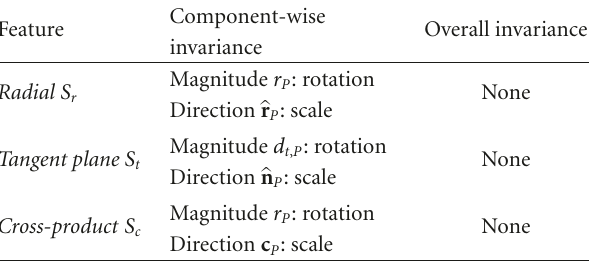
Table 2: Local geometric features and their invariance properties (assuming that the barycenter of the surface M is at the